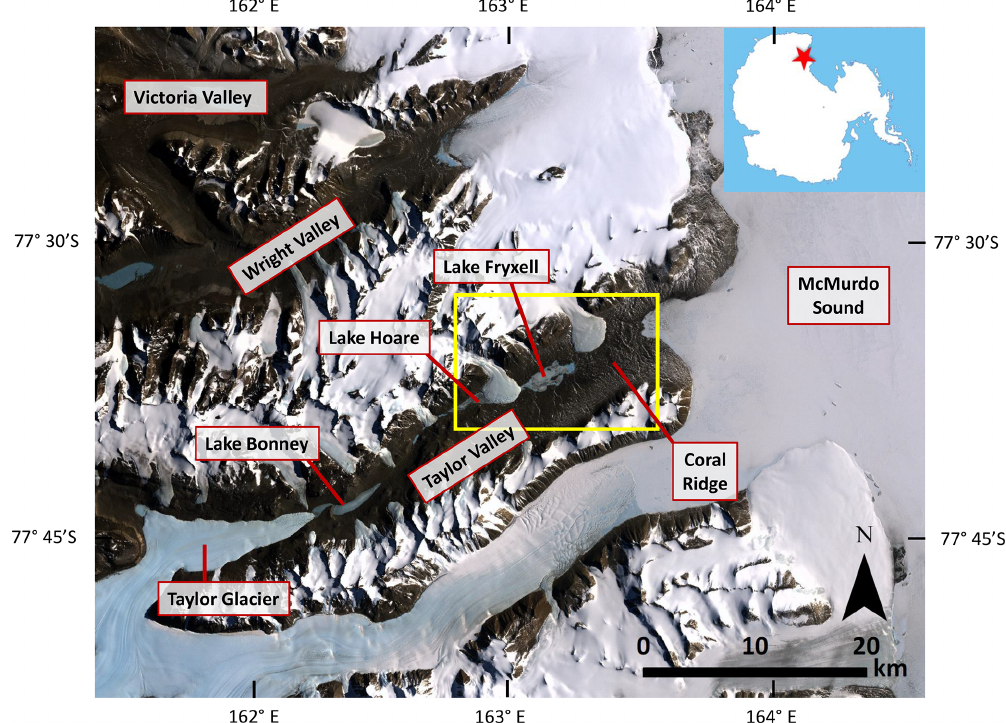
Figure 1. Overview map of the McMurdo Dry valleys. Lake Fryxell is located in the eastern portion of Taylor Valley, and the study area is outlined in yellow. Satellite imagery from Landsat Imagery Mosaic Antarctica (LIMA) published 2009.